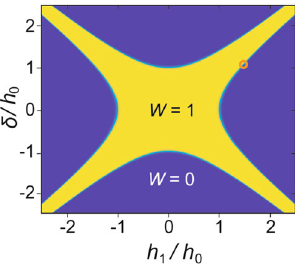
Fig. 6 Topological phase diagram. The yellow area with winding number W = 1 corresponds to the topological nontrivial phase, the blue area with winding number W = 0 corresponds to the topological trivial phase. The orange circle at the boundary denotes a phase transition point where ¼ 1 : 05 and δ ¼ 1. coupling parameters h 1 h h 0 0